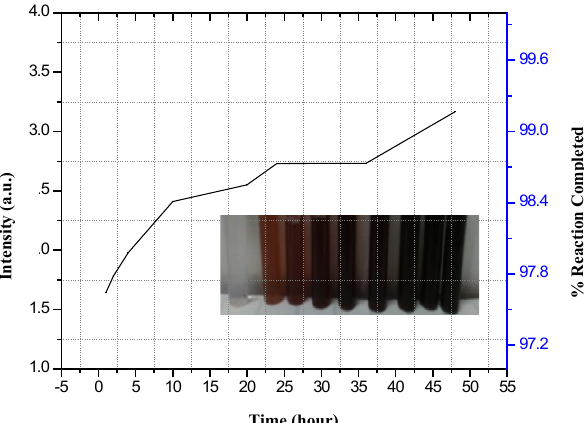
Fig.1. (b) RAgNPs: Intensity graph of reaction mixture containing aqueous 3mM AgNO 3 solution treated Root Water extract (RWE) versus time (hour) showing that the 90% of NPs biosynthesis completed within 2 hr. Inset: increase in the color intensity of the reaction mixture Fig.1 (a): SAgNPs: Intensity graph of reaction mixture containing aqueous 3mM AgNO solution treated with Stem 3 Water extract (SWE) versus time (hour) showing that the 90% of SNPs biosynthesis completed within 2 hr. Inset: with time. increase in the color intensity of the reaction mixture with time.